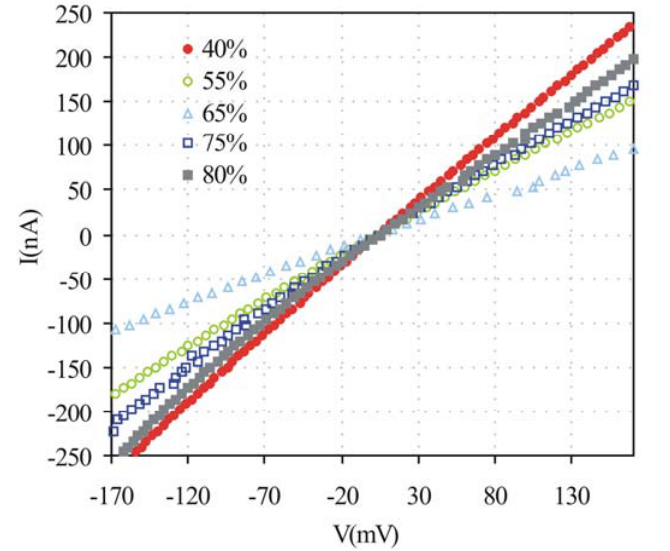
Figure 8. The effect of humidity over current voltage characteristics of SWCNTs detected through the free electrodes.